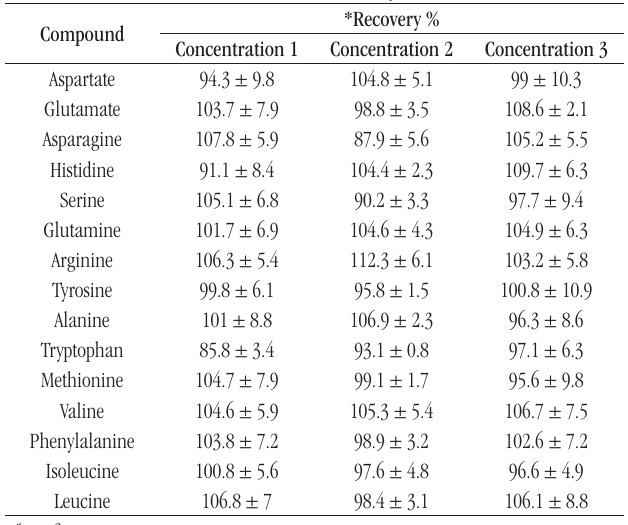
taBLE 5 − Recovery